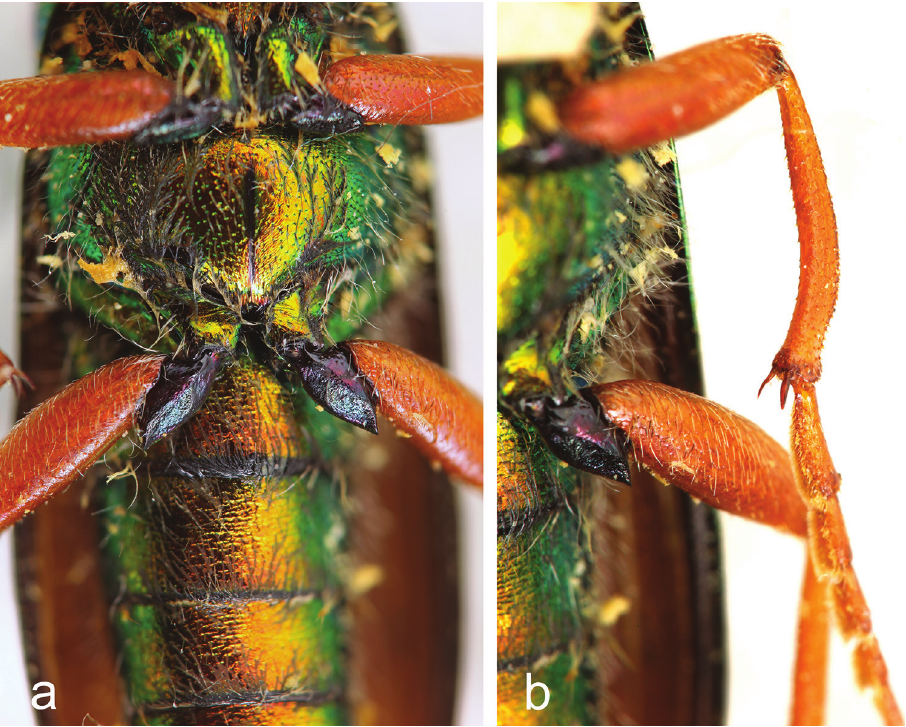
Figures 3. Teratolytta krejciki sp. n., male: a metasternum and metatrochanters b mesotibiae and meso-